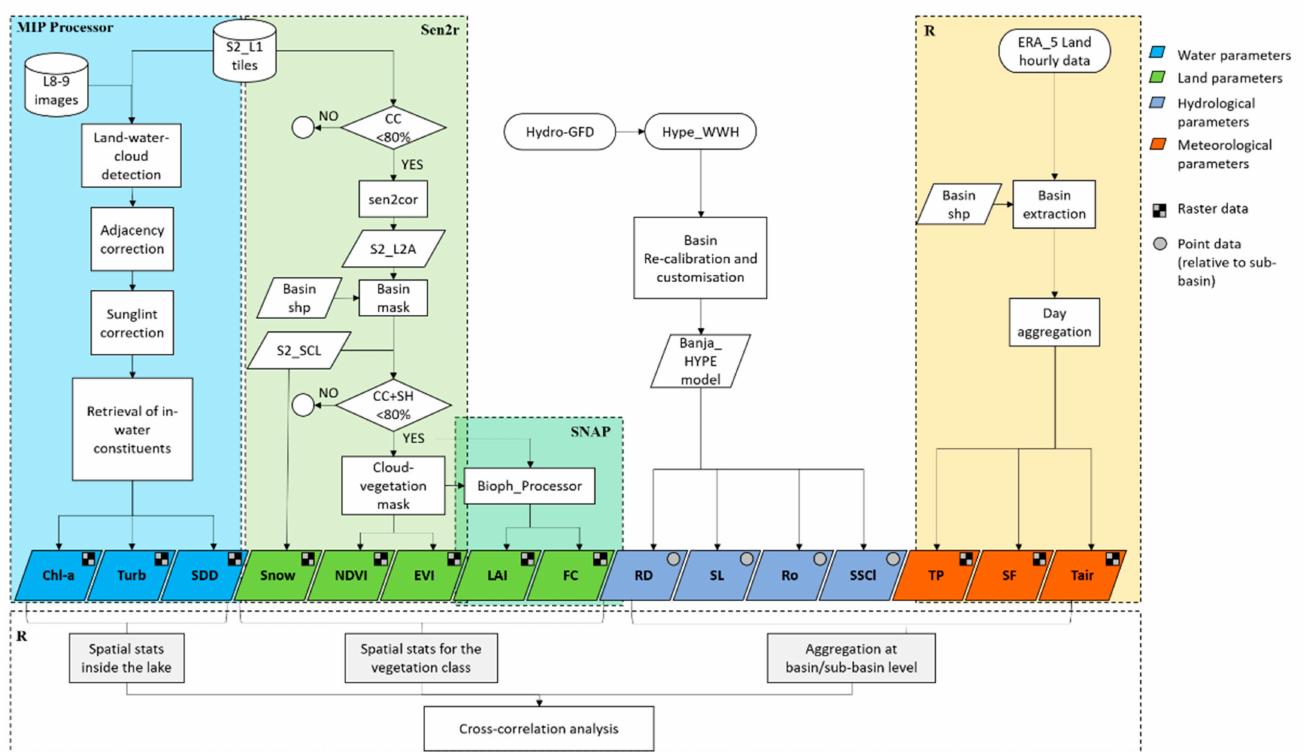
Figure 2. Processing scheme for the retrieval and the analysis of water, land, hydrological, and meteorological